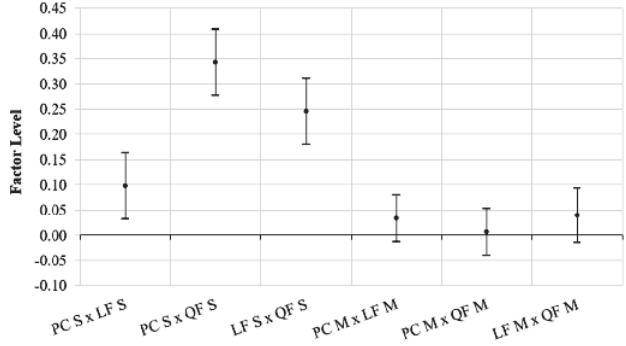
Expansion of the mortar bars ARI, LF and QF exposed to solutions of Na for 42 and 140 days (6 and 20 weeks)